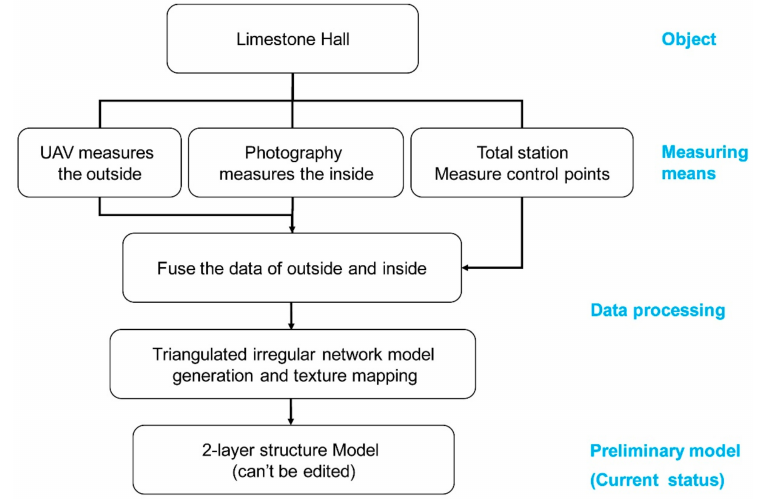
Figure 6. Mapping and modeling flow diagram of architectural heritage with multilayer